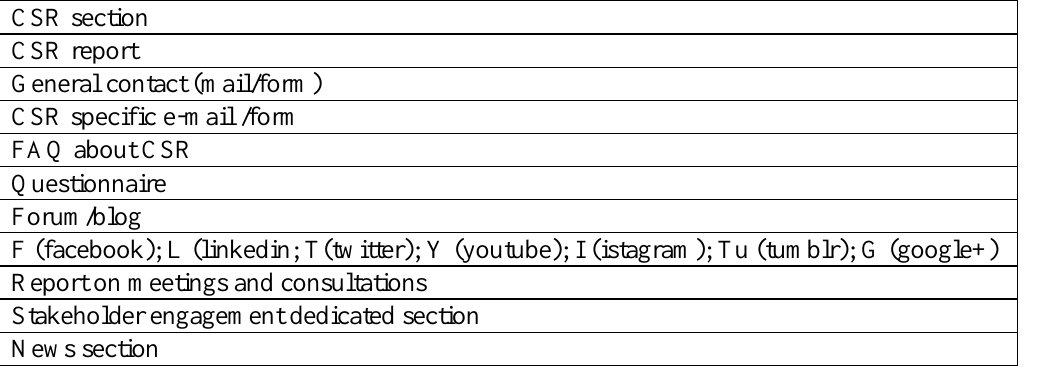
Table 2: Relevant Dimensions Investigated CSR